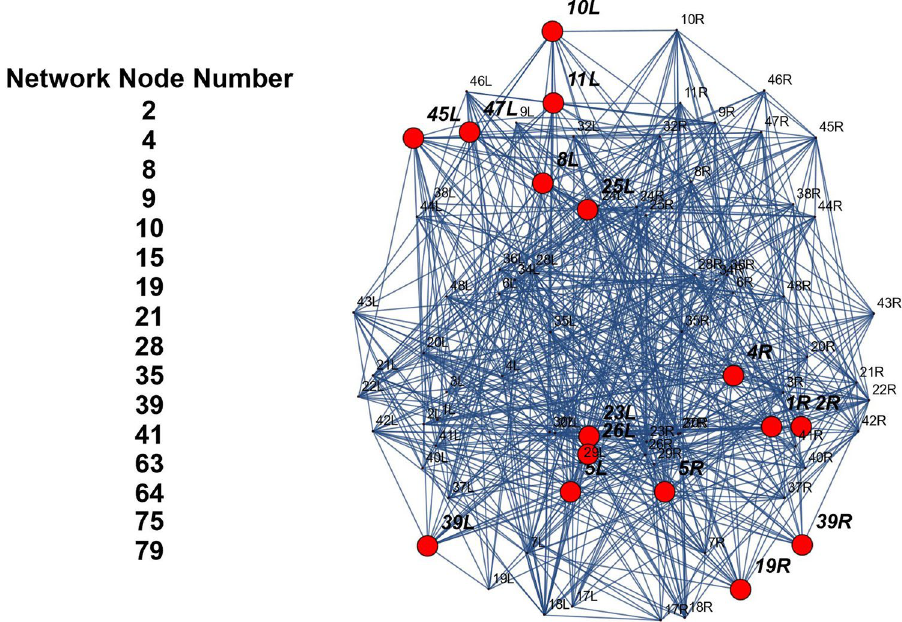
Figure 4. The image shows the 16 nodes of the network that produces the Action–Execution behavior.